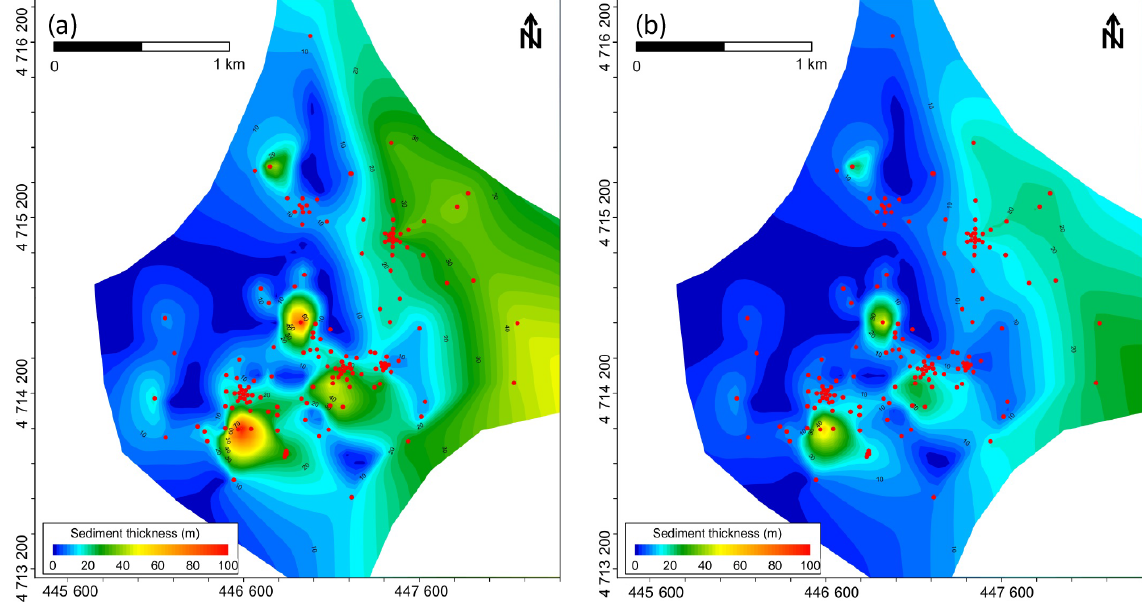
Figure 11. Contour map showing the sediment thickness obtained from interpolation of thickness values obtained from H / V frequencies (Fig. 10) using (a) V s = 500 and (b) 290ms − 1 . Map is shown in UTM coordinates in m, ETRS89